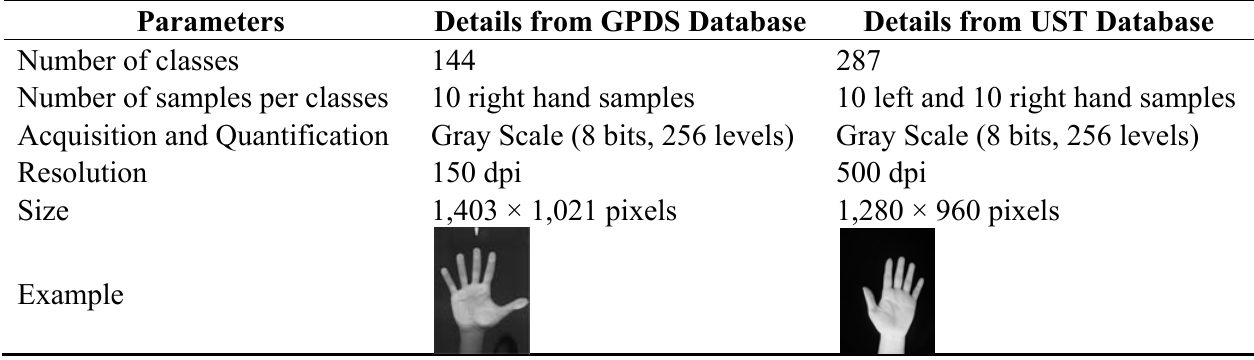
Table 1. Characteristics of both